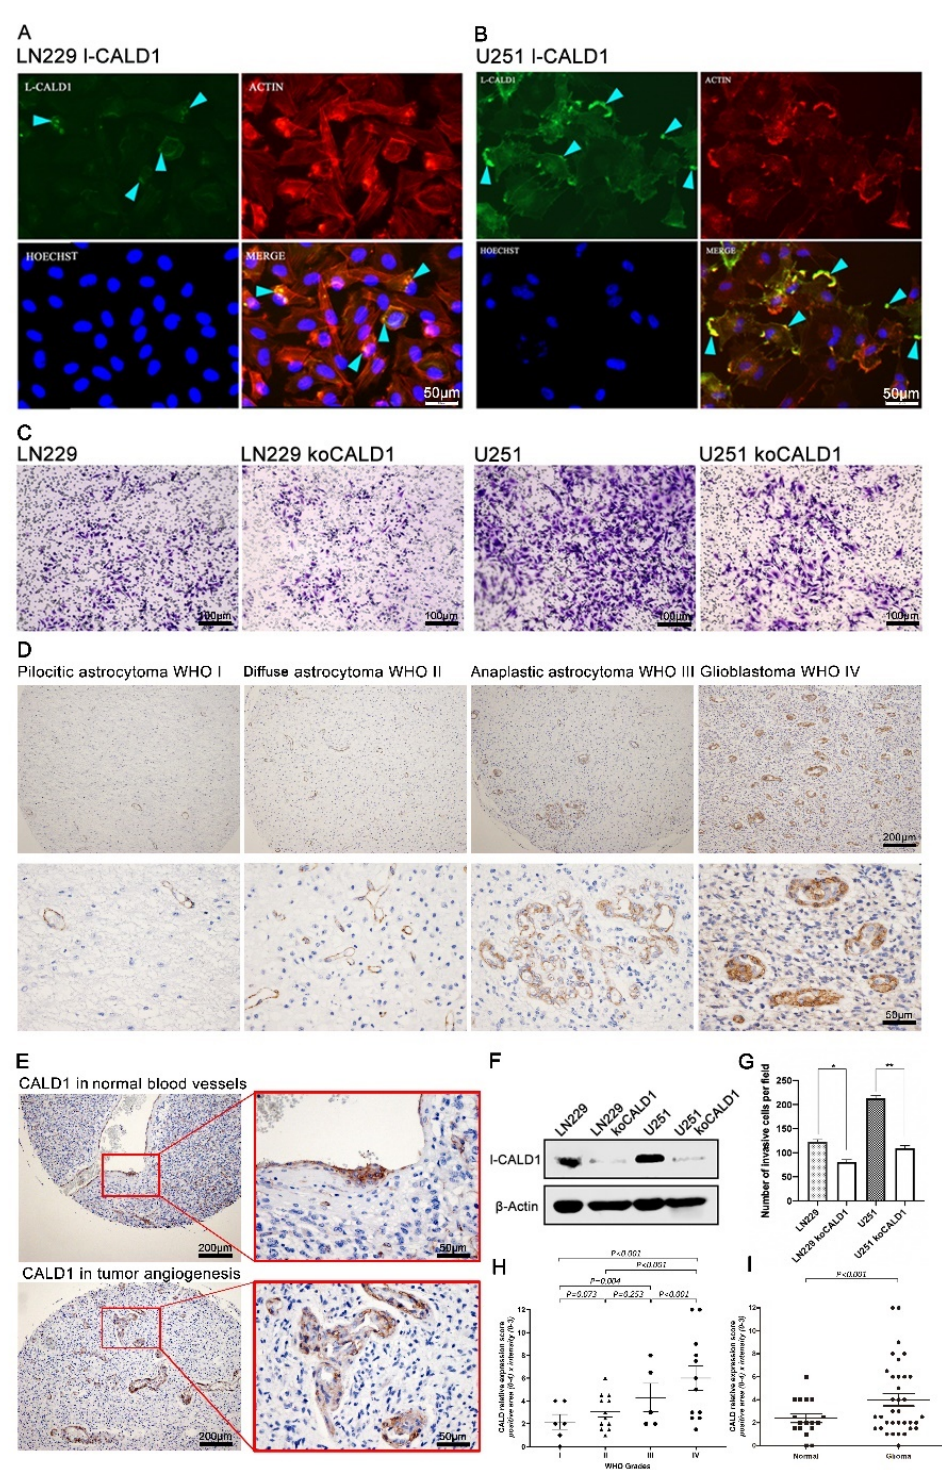
Figure 4. CALD1 facilitates GBM cells moveability in vitro and associates with tumor progression in pathological angiogen- esis. ( A ) Immunofluorescent staining of l-CALD1 in cell line LN229. ( B ) Immunofluorescent staining of l-CALD1 in cell line U251. ( C ) Knock-out l-CALD1 affected mobility of GBM cells. ( D ) IHC staining of l-CALD1 in glioma cases according to WHO grades progression. ( E ) Comparing l-CALD1 in normal blood vessels and tumor angiogenesis. ( F ) Measurement of CRISPR/Cas9 knock-out l-CALD1 efficiency in U251 and LN229 by protein level. ( G ) Statistics of GBM cells mobility after koCALD1. ( H ) Statistics of comparing l-CALD1 expression level according to WHO grade progression. ( I ) Statistics of comparing l-CALD1 expression level in normal blood vessels and tumor angiogenesis. *: p value < 0.05; **: p value <